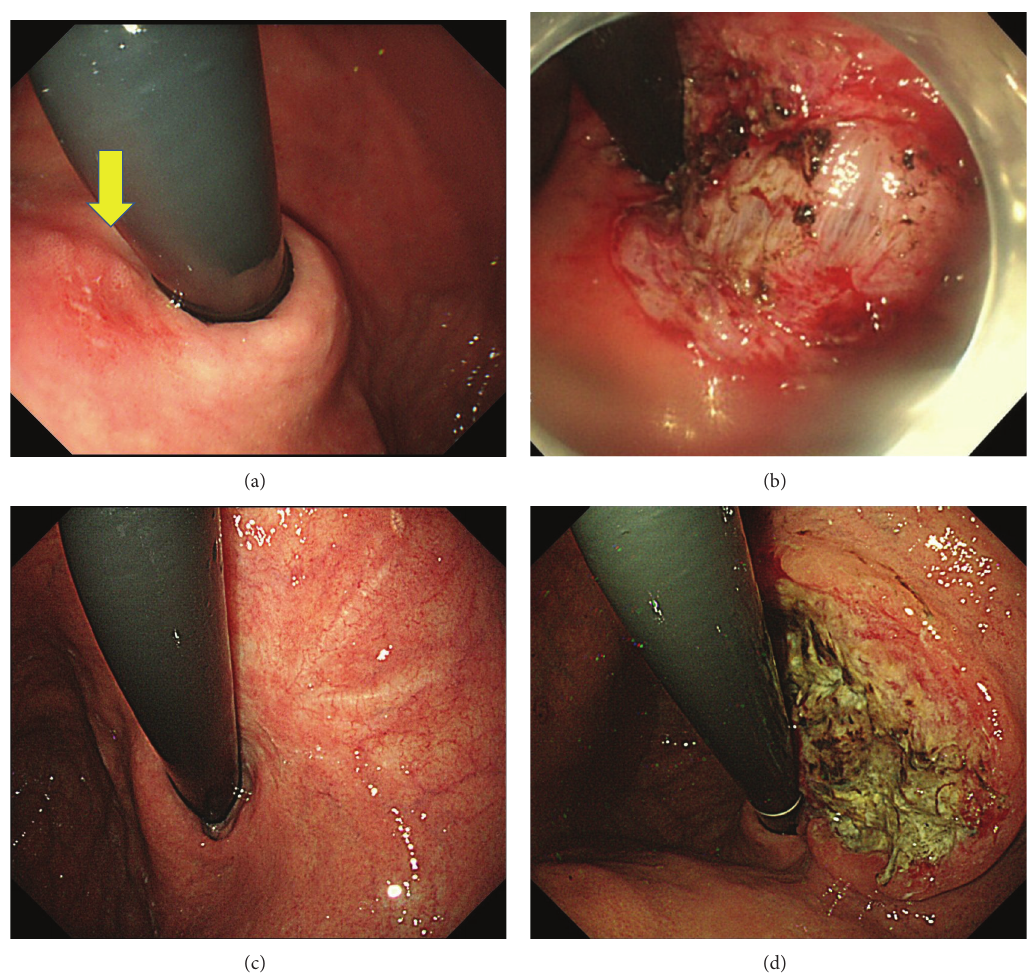
Figure 1: (a) Endoscopic findings of the first EGD revealed the small depressed type of early gastric cancer of the posterior wall of the cardia (arrow). (b) Endoscopic findings after submucosal dissection. En block resection was obtained by ESD method. (c) Endoscopic image 24 months after ESD. There was no evidence of recurrence. (d) Endoscopic image 30 months after ESD. Local recurrence of the type 2 advanced gastric cancer was found.